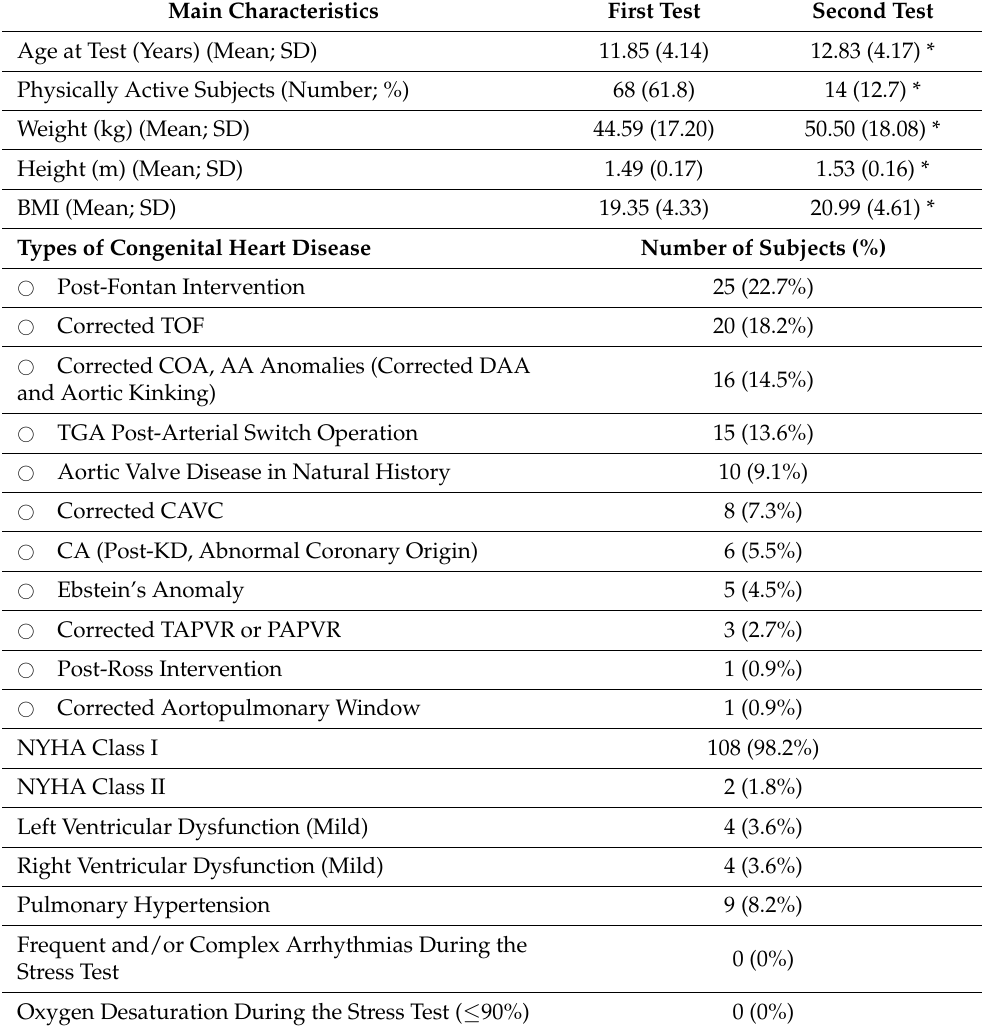
Table 1. Main characteristics and type of pathology in 110 young patients with congenital heart disease who composed the study population. * = p <